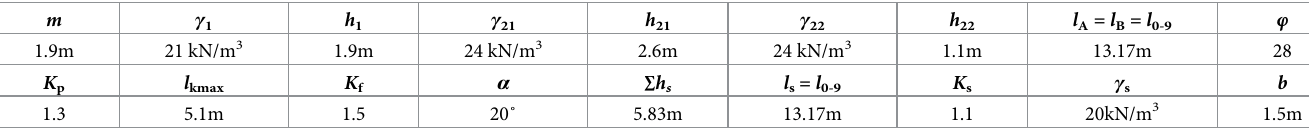
Therefore, the breakage of the second and third stratum in Table 10 are not influenced by each other. Therefore, the load and the breaking length of each stratum can be calculated indepen- dently by Eqs (21) and (5). Table 11 shows the calculation results. So, the breaking length of the main roof is 13.17m. Through Eqs (1), (2), (4), (29) and (30). the MSSC in No.9 coal seam is 3560.03kN based on the parameters in Table 12. No.5 coal seam. Fig 13 shows the roof structure characteristic after No.5 coal seam min- ing. The interaction system between the shield and roof strata is composed of the shield, canti- lever beam of the immediate roof, and voussoir beam of the main roof. And the load on the rock blocks A and B of the voussoir beam of the main roof is the given load of overburden strata ( q ). The roof structure is named the voussoir beam balanced structure. And the MSSC 0 ( P ) includes the weight of the immediate roof ( Q ) and the force acting on the shield when the 0 rock blocks of the voussoir beam are generated by thick main roof slip instability ( F ). Table 12. Calculation parameters of MSSC in No.9 coal